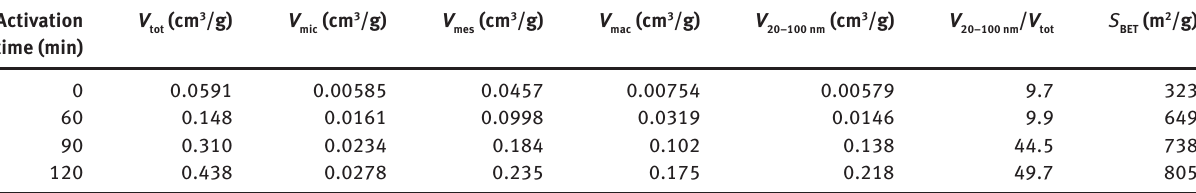
Table 3 Effects of activation time on pore volume, and specific surface area ( S 850 ° C).